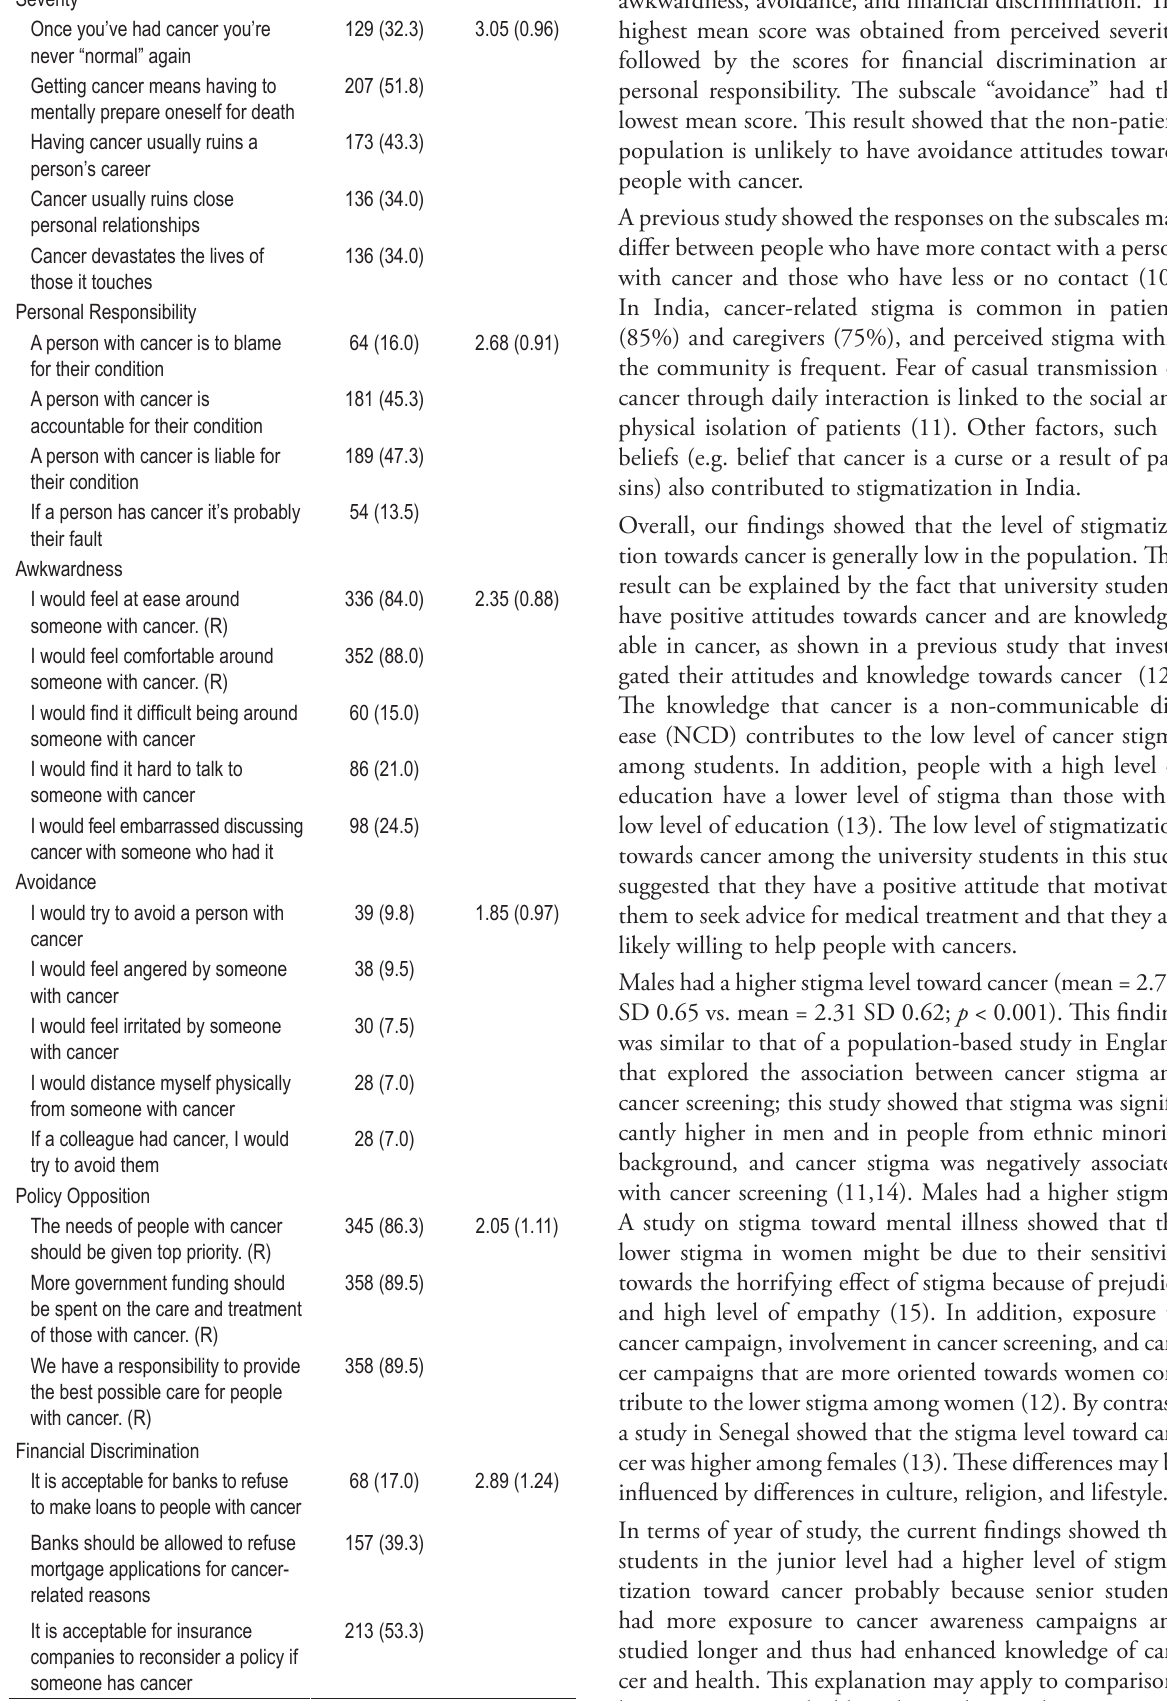
TABLE 2. Agreement with each of the cancer stigma items in the study participants ( n =400) Cancer